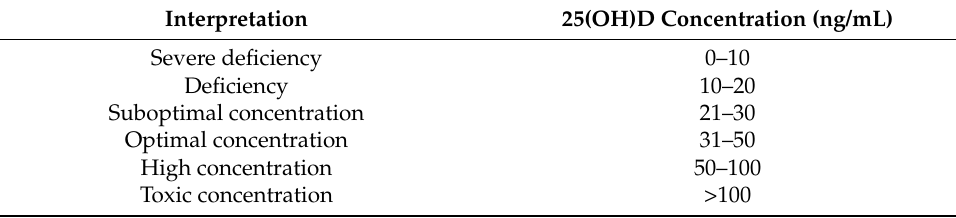
Table 1. Definition of vitamin D status according to the 25(OH)D concentration for Central